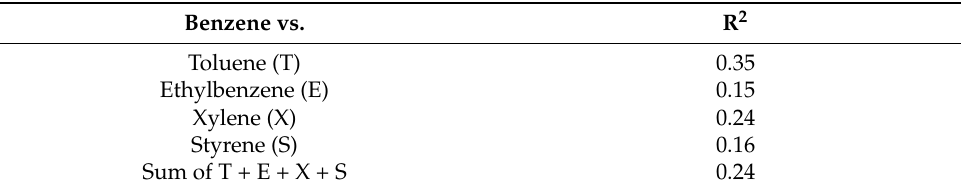
Table 10. Correlations of benzene concentration with other measured VOC